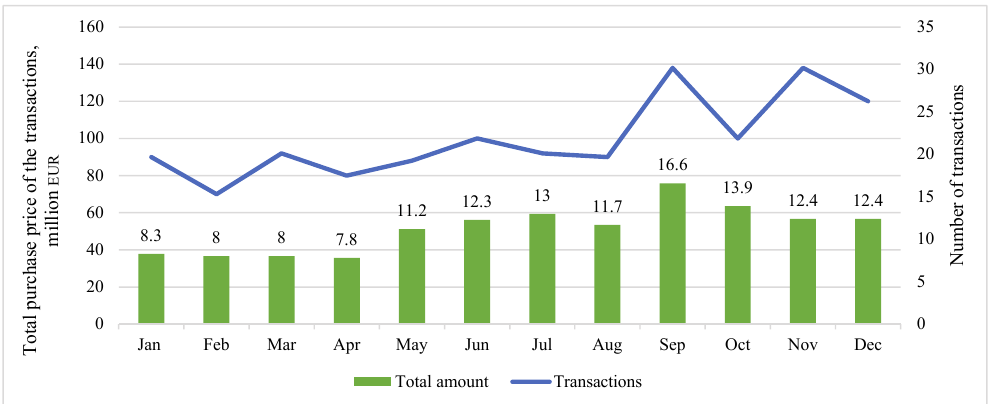
Fig. 6 . Dynamics of the total purchase price and the number of transactions with the new apartments in Riga, 2015, million EUR (developed by the authors based on the data from the Land Registry of